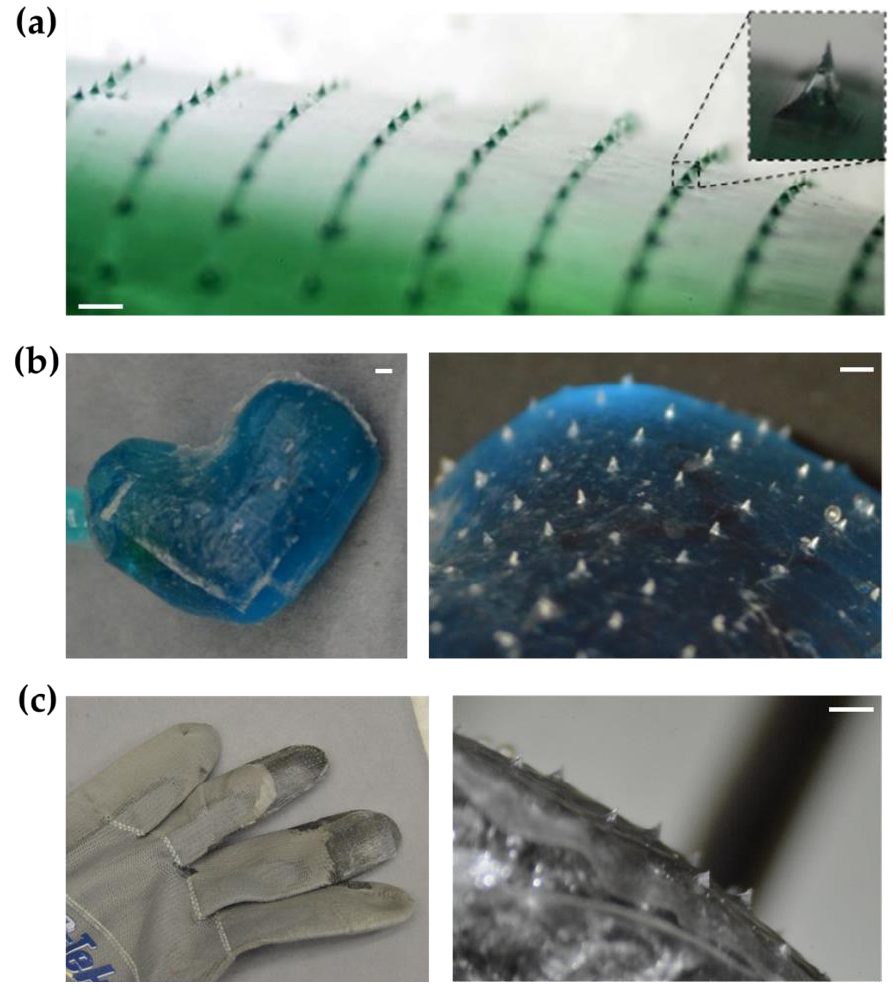
Figure 4. Examples of microneedle patterning on nonplanar surfaces. ( a ) Wide curved surface; ( b ) Left atrial appendage balloon occlusion device with patient-specific design; ( c ) High-friction glove. Scale bar, 1 mm.